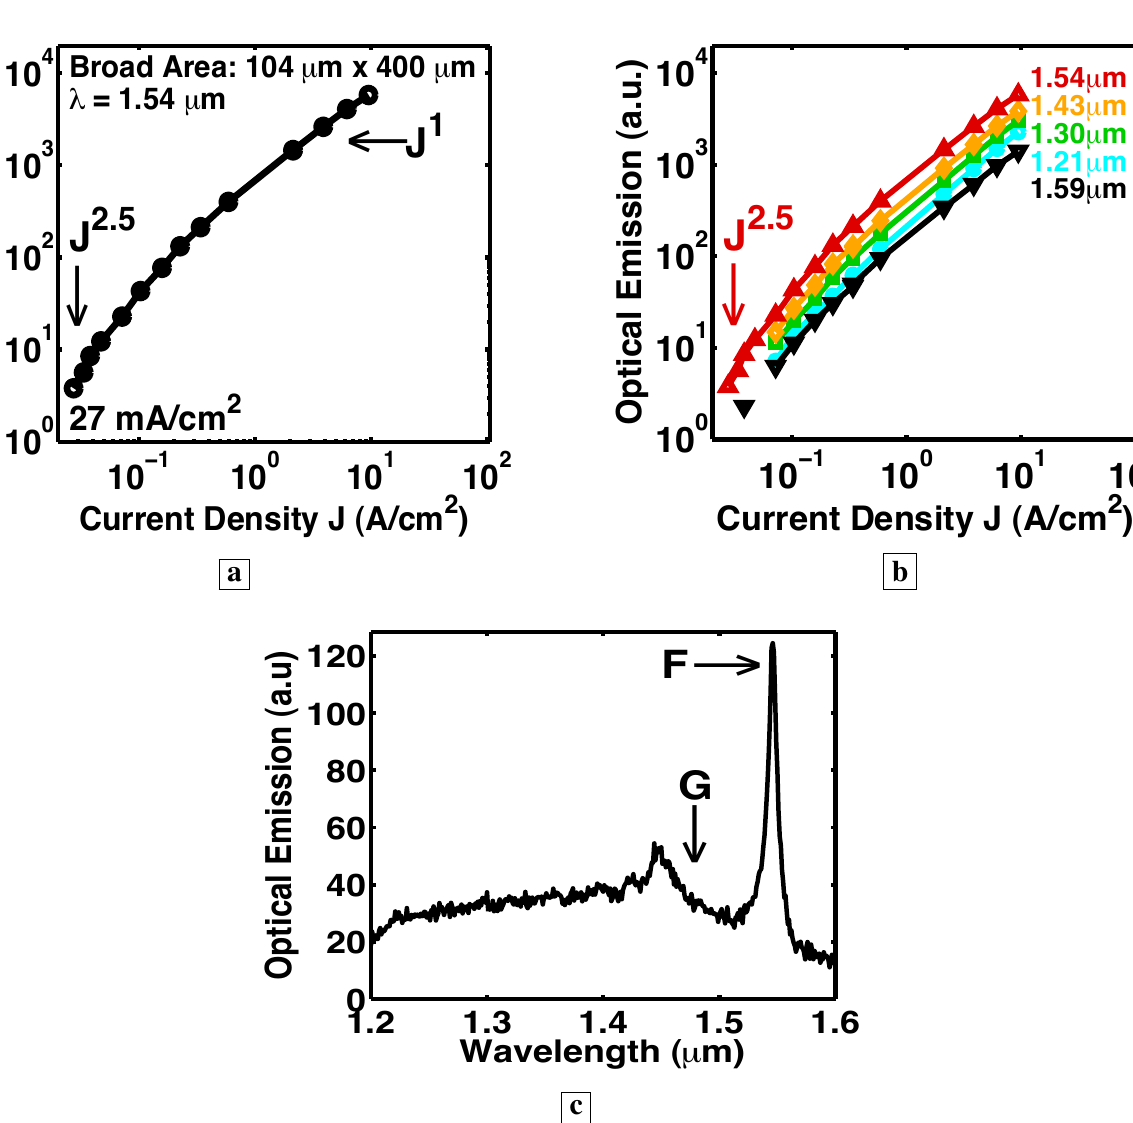
Figure 19 . Room-temperature measurements in cw-mode from a resonant cavity. a, The stimulated-emission at 1.54 µ m from Sample N rises as J 2 . 5 , beyond which the optical-emission quickly becomes linear in J. The threshold current density is observed to be less than 27 mA/cm 2 . b, The constant vertical separation on a log-log plot of the L-I curves at different wavelengths from the same pixel indicates that the optical-emission has the same spectral shape for all indicated J, and that the carrier distribution is pinned among the energy-levels. (Without the resonant cavity, the optical emission shows a significant shift in the population distribution with increasing injection.) c, Optical emission spectrum from Sample N at 25 A/cm 2 . With a resonant cavity, the low-loss TIR mode, labeled G in Figure 19c, is suppressed, while the lossy vertical mode, labeled F in Figure 19c, dominates the spectra as a narrow peak. Thus, enough material gain exists to overcome the large 70% transmission loss incurred by the vertical mode with each trip to the sample